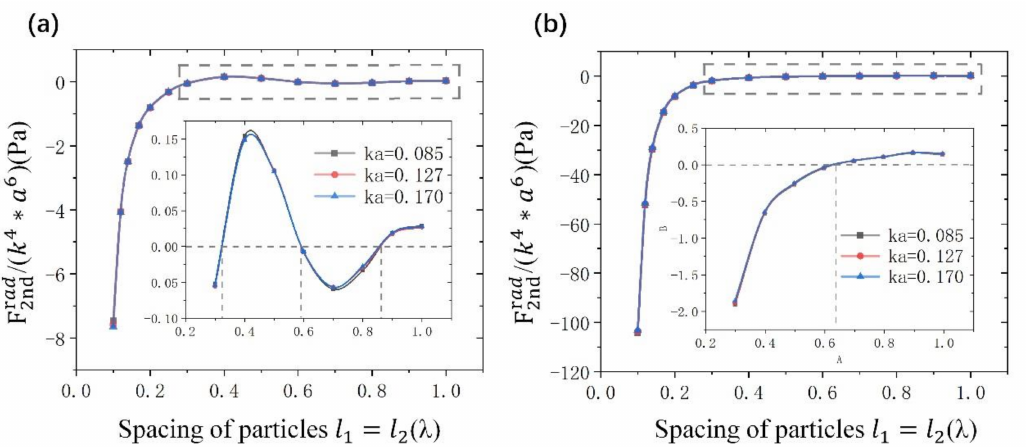
Figure 6. Interaction between four equidistant particles. ( a ) Internal particles and ( b ) external